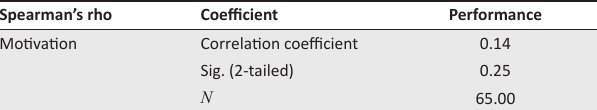
TABLE 8: Correlation analysis between Public Sector Motivation and Individual Job Performance. Spearman’s rho